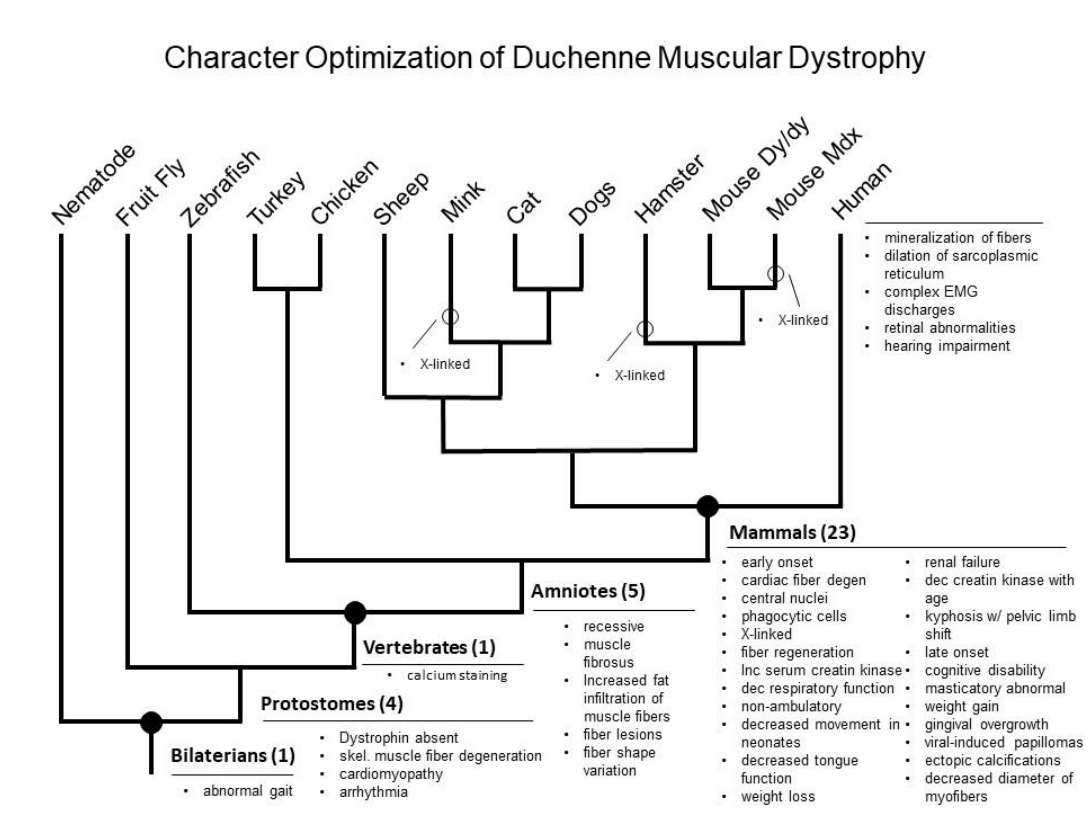
Figure 1. Character Optimization – DMD Symptoms. DMD symptoms are most commonly attributed to Mammals, though there are symptoms that characterize each node within the clade of animals studied. Open circles indicate possible loss of a